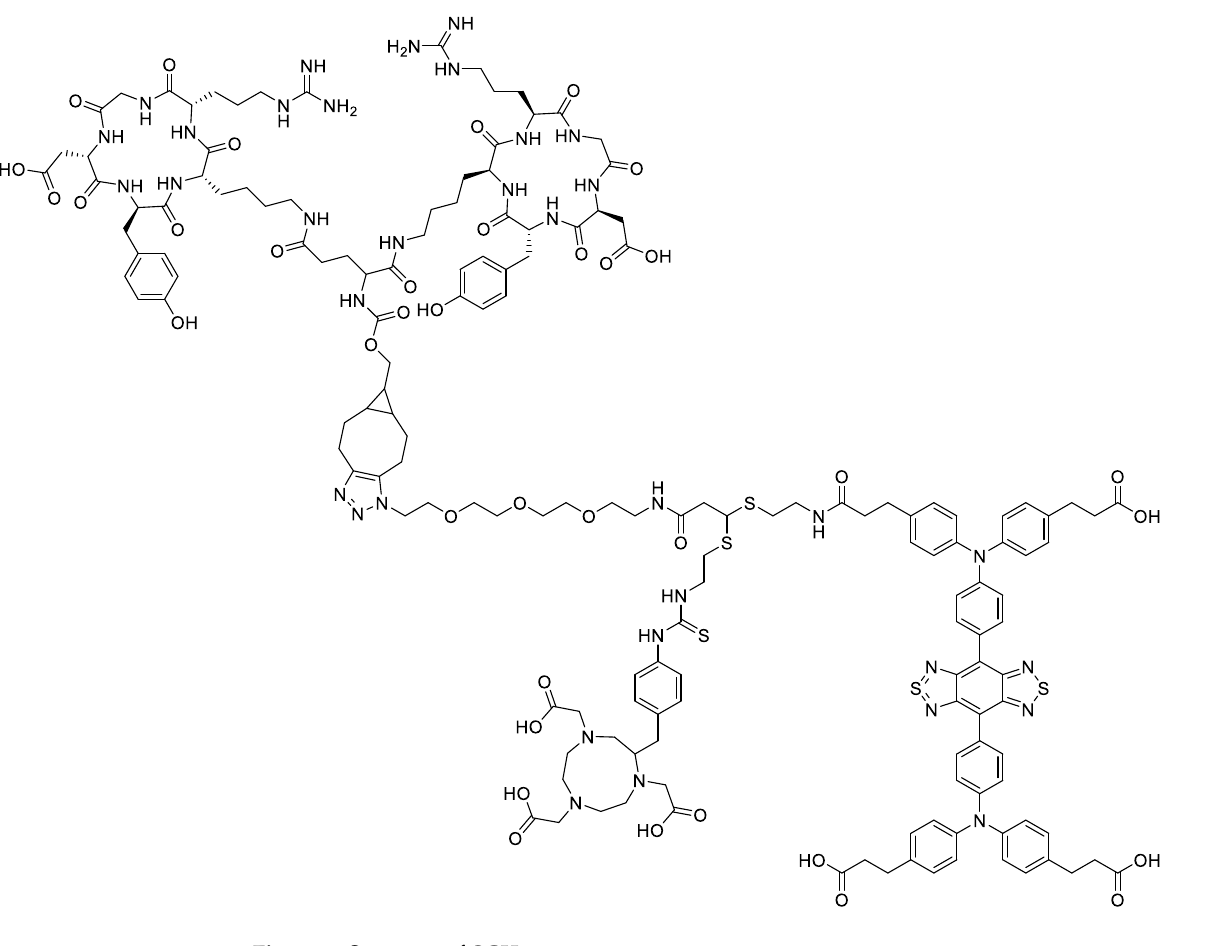
Figure 7. Structure of SCH2 .